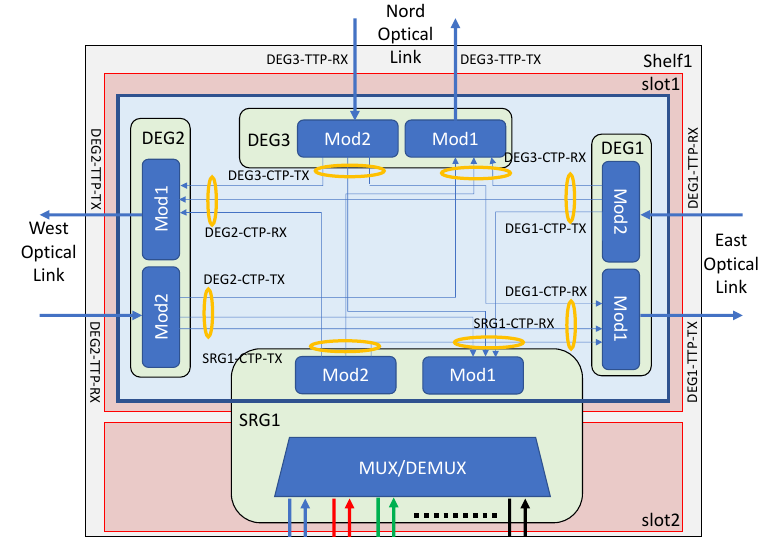
Figure 3. Example schema of an ROADM device.